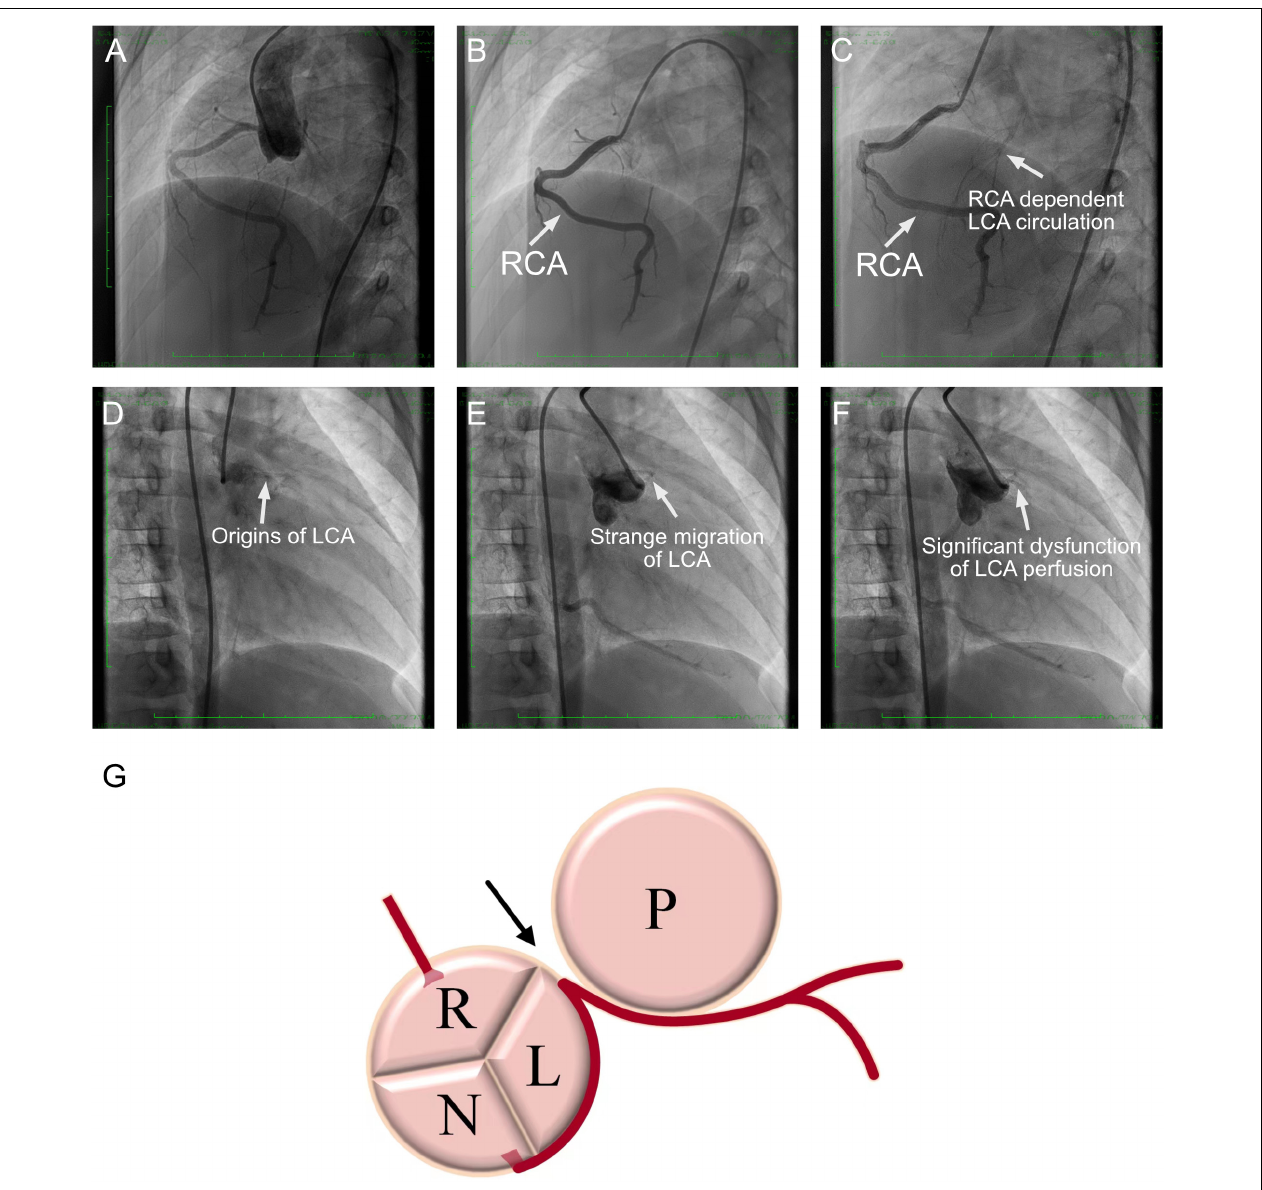
FIGURE 4 | Coronary angiography images. (A) Angiography at the root of the aorta. The right coronary artery could be perfused with contrast agent, but the left coronary artery was missing. (B) Selective right coronary artery angiography demonstrated a dilated right coronary artery. (C) Delay radiological exposure revealed that the left ventricle could be supplied by the right coronary artery, which was considered the right coronary artery-dependent left coronary artery circulation. (D) The angiography failed to illustrate the left coronary artery in the left coronary sinus. (E) A strange curve-like migration of the origin of the left coronary artery by angiography at a superior location. (F) Then, the left coronary artery could be perfused at an extremely low volume. (G) Anatomic aspect of the axial section of aortic and pulmonary valves and left coronary artery arising from the non-coronary sinus of Valsalva with an intramural segment course. RCA, right coronary artery; LCA, left coronary artery; R, right coronary sinus; L, left coronary sinus; N, non-coronary sinus; P, pulmonary